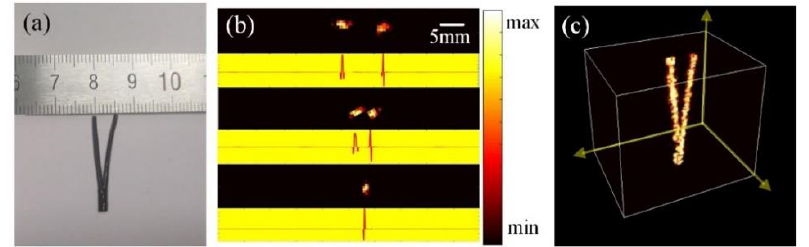
Figure 9. ( a ) Photograph of a blood vessel phantom, ( b ) PA images and A-lines of several B-scans, and ( c ) 3D photoacoustic image.